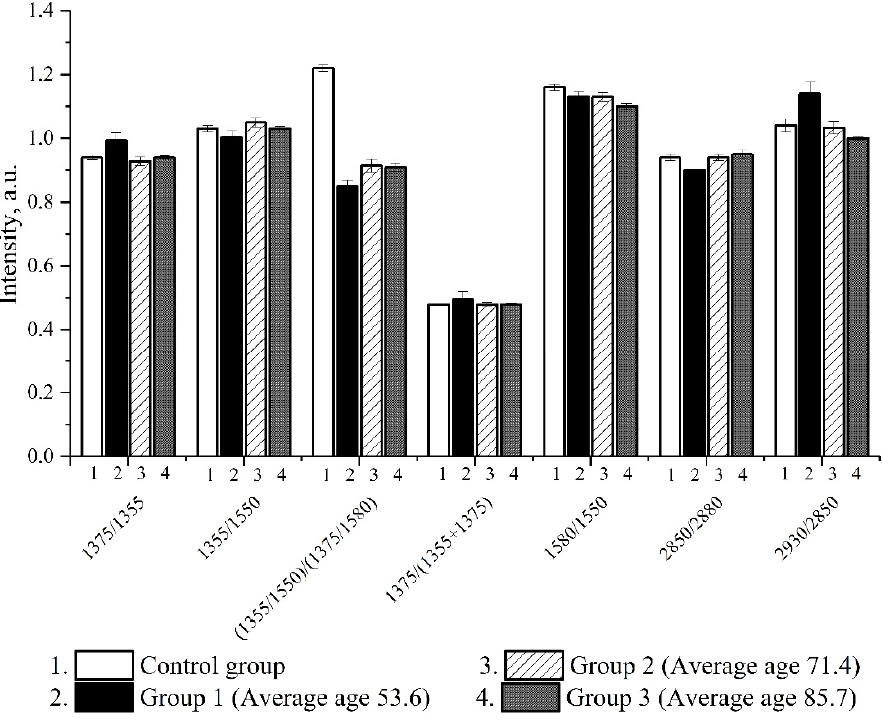
Figure 2. Changes in hematoporphyrin conformation and the ability of hemoglobin to transport oxygen in COVID-19 patients of different age groups.